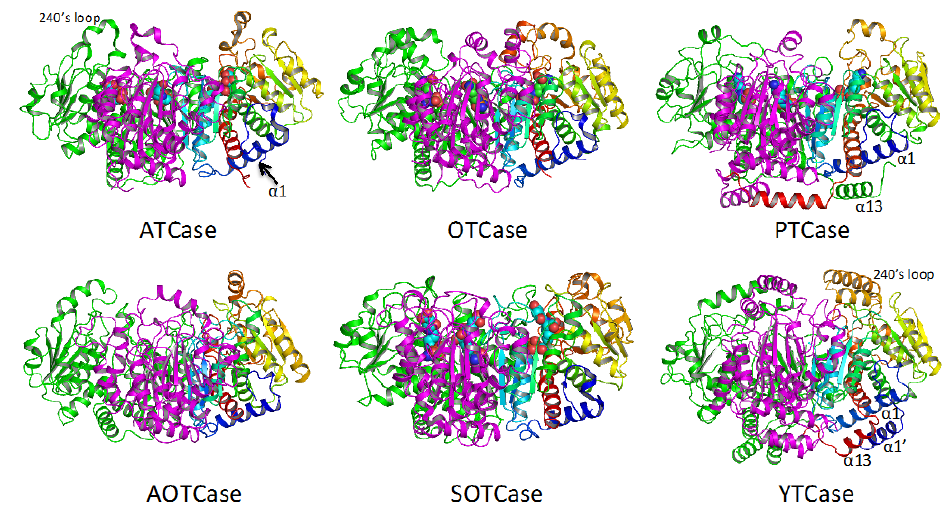
Figure 5. Ribbon diagram of the catalytic trimer of Escherichia coli ATCase, E. coli OTCase, Enterococus faecalis PTCase, Xanthomonas campestris AOTCase, Bacteroides fragilis SOTCase and E. coli YTCase, viewed perpendicular to the three-fold axis. Different subunits are shown in different colors (rainbow, green and magenta, respectively). The bound substrates or inhibitors are shown as space-filling